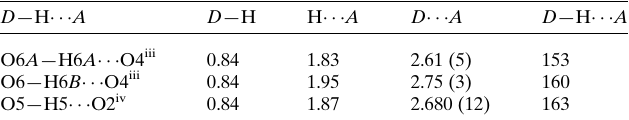
Table 3 Hydrogen-bond geometry (A˚ , (cid:4) ).